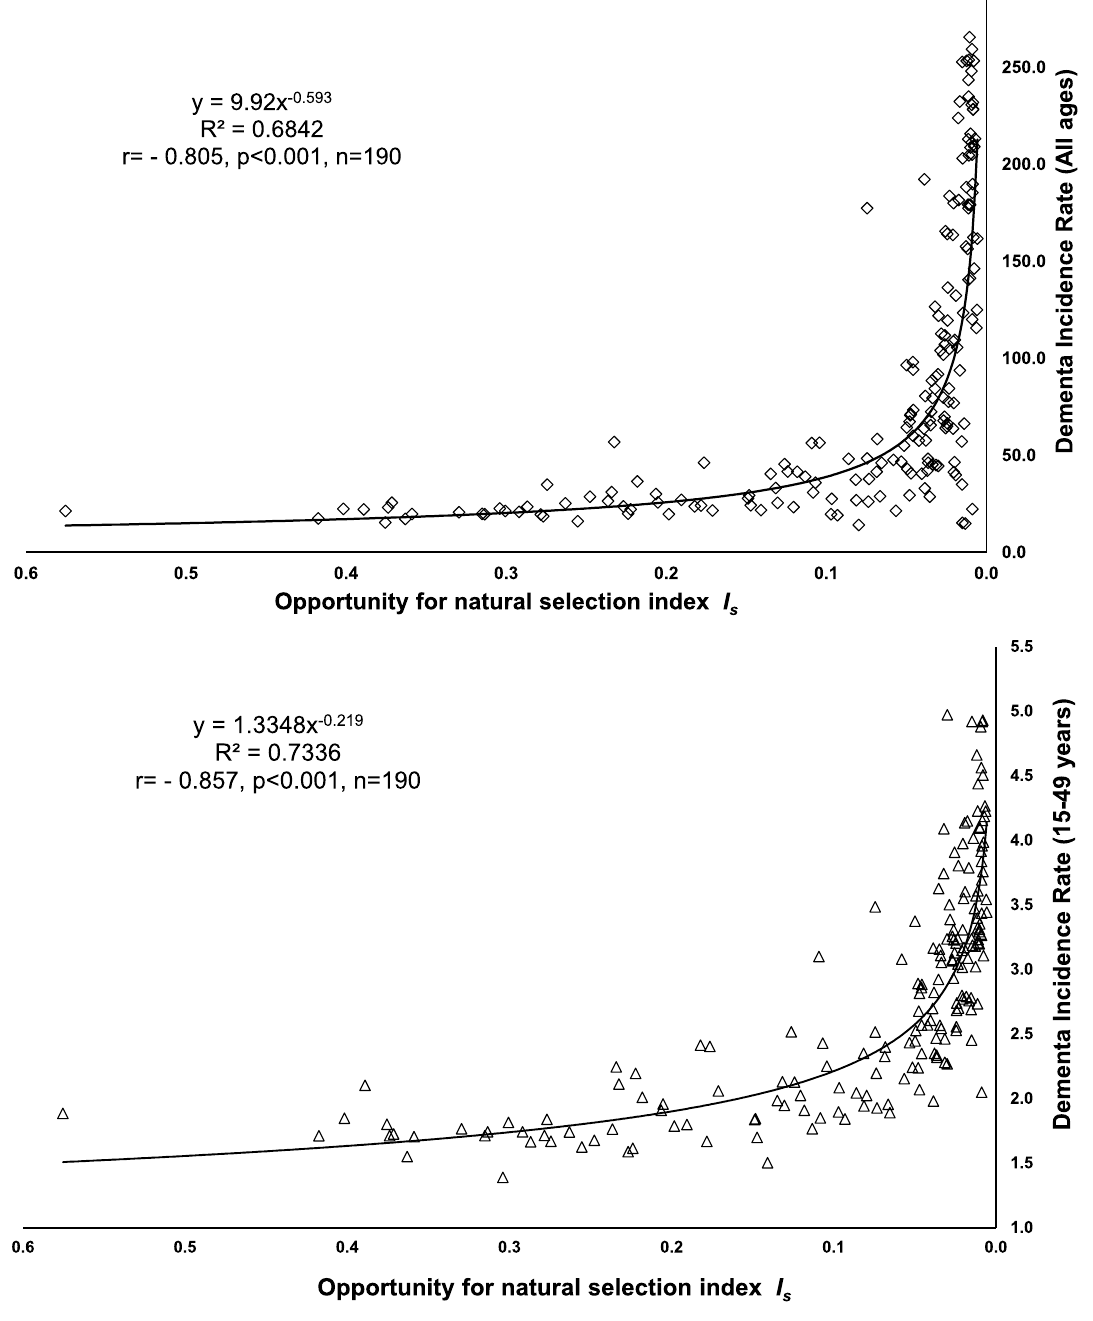
Figure 2. The relationships between opportunity for selection I s and dementia incidence in populations of full age range and in 15–49 years old population